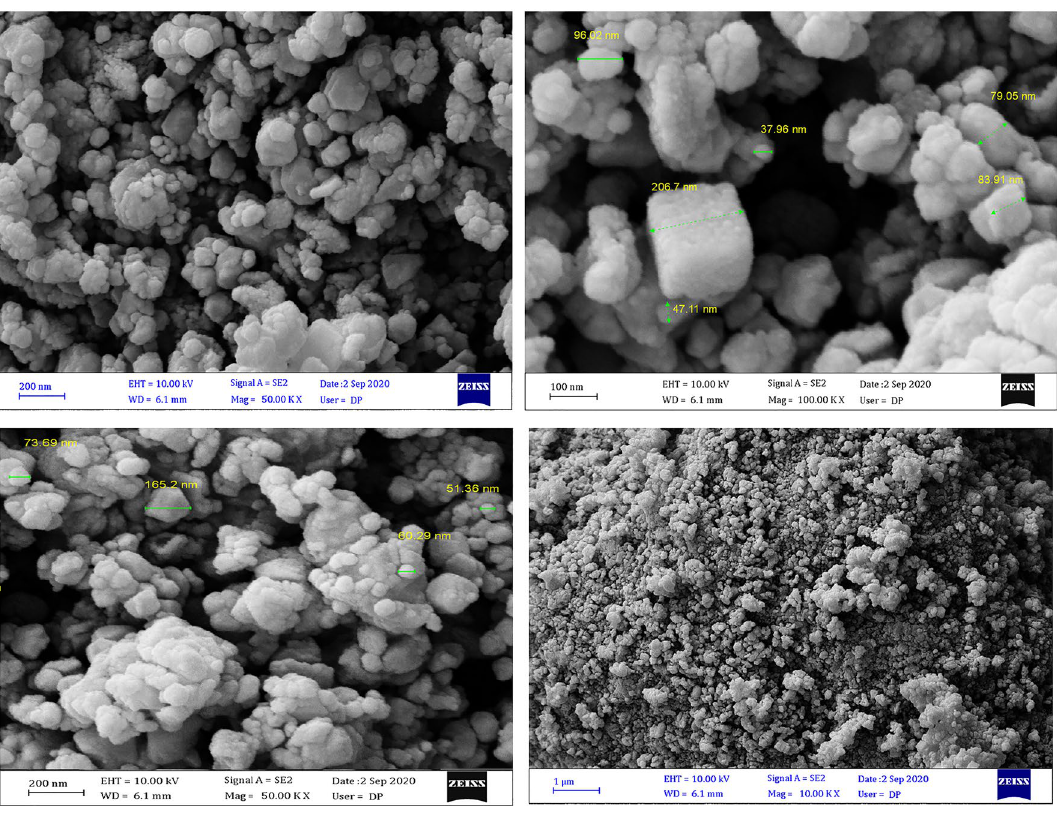
Figure 7. FESEM of Fe 3 O 4 @SiO 2